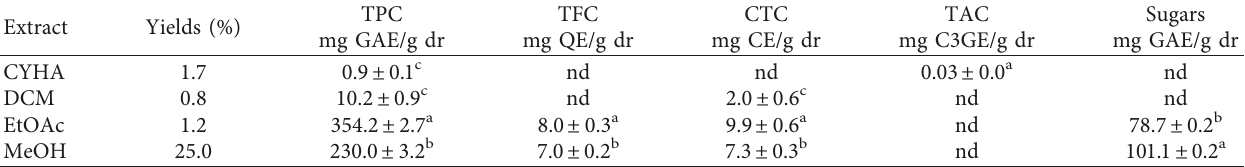
Table 1: Chemical compositions of M. mabokeensis Aubr´ev bark extracts.